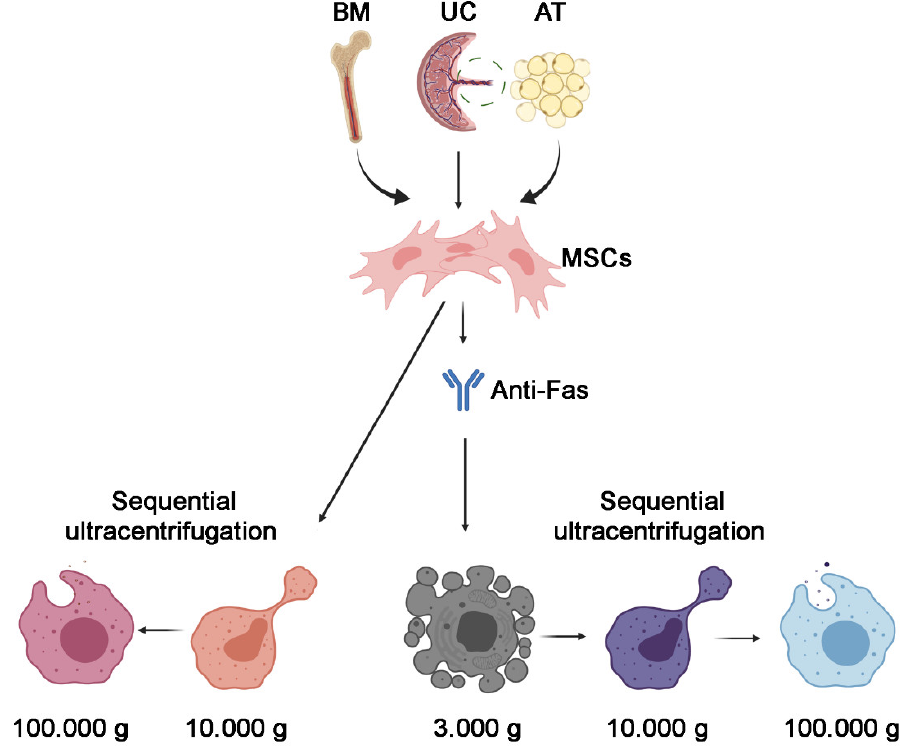
Figure 1. Scheme of different EV fractions used in this study. Naive and apoptotic MSC EVs, induced with anti-Fas antibody, obtained from bone marrow (BM), the umbilical cord (UC) or adipose tissue (AT) were isolated using subsequent differential ultracentrifugation. Figure was created using BioRender licence number BO233A7CUA.